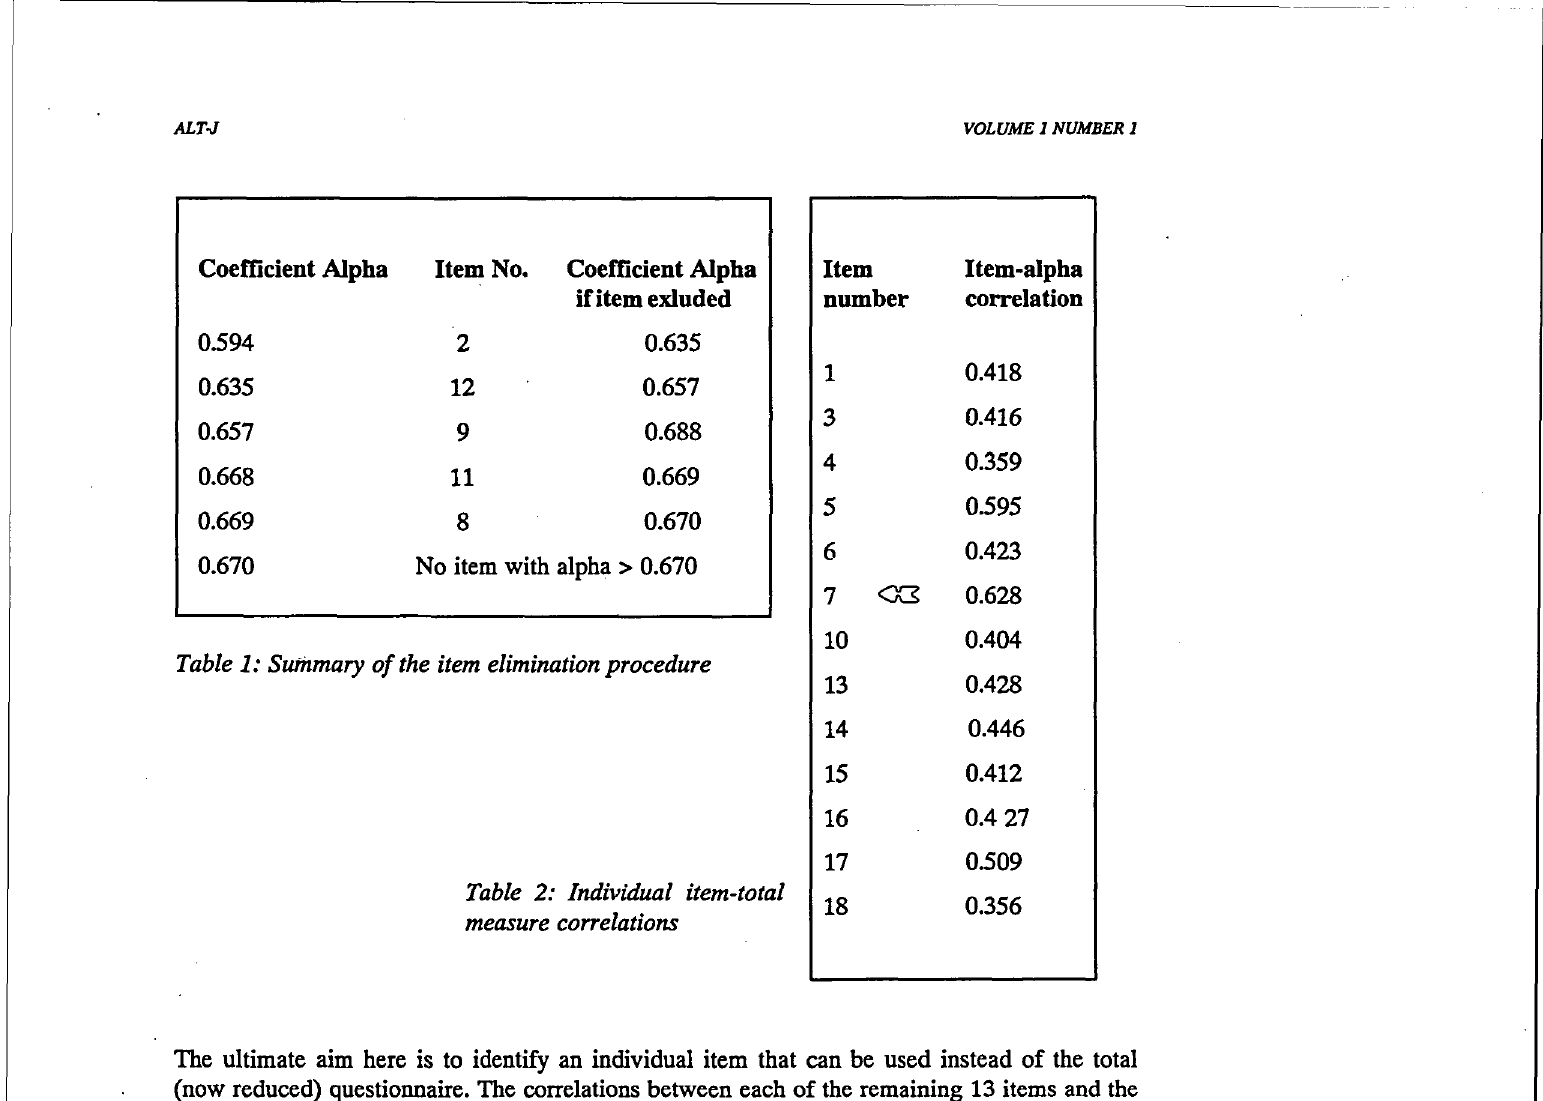
Table 2: Individual